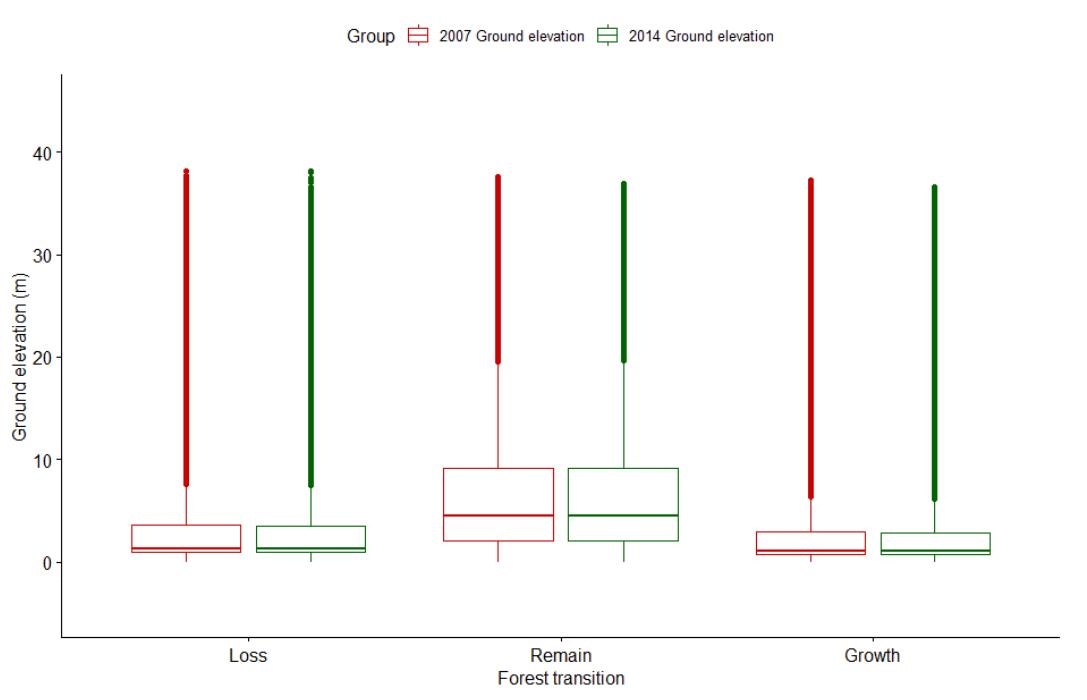
Figure 6. Comparison of ground elevation from 2007 and 2014 between the forest transition classes.